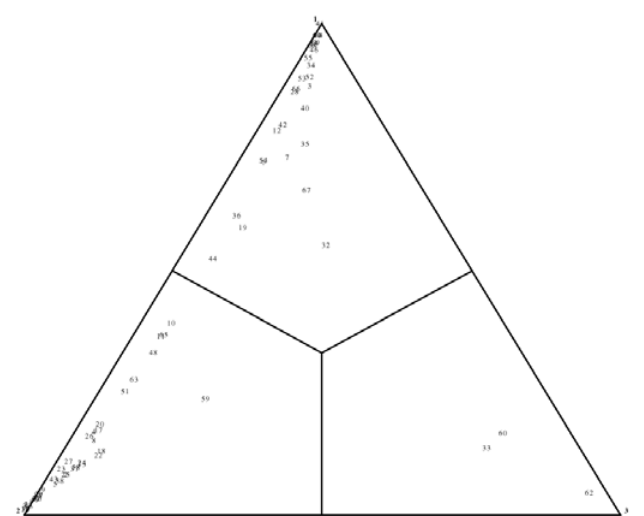
Fig. 5 - Fuzzy clustering in a ternary plot (fuzziness f= 2.25), utiliz- ing the absolute value’s differences for the two compared years between 69 cultivars for saturated, monounsaturated and poly- unsaturated FAs (From: Lombardo et al .,